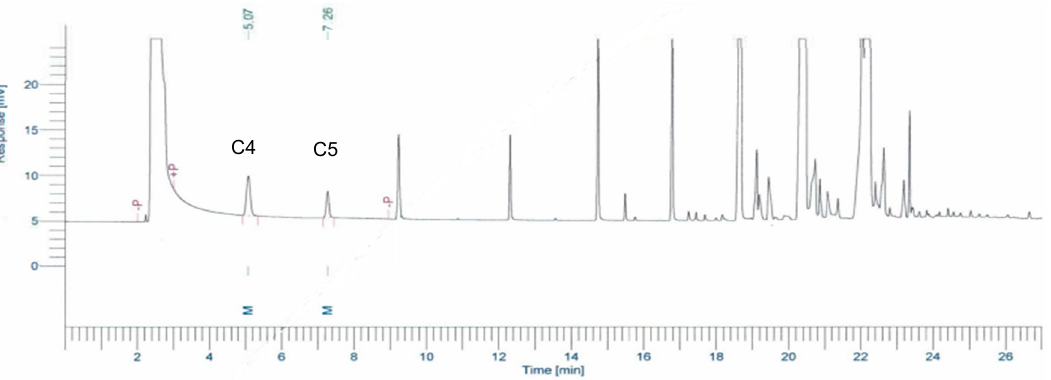
Figure 1. Chromatogram of butyric acid (C4) and valeric acid (C5) methyl esters in blended fat spreads analyzed by GC-FID.